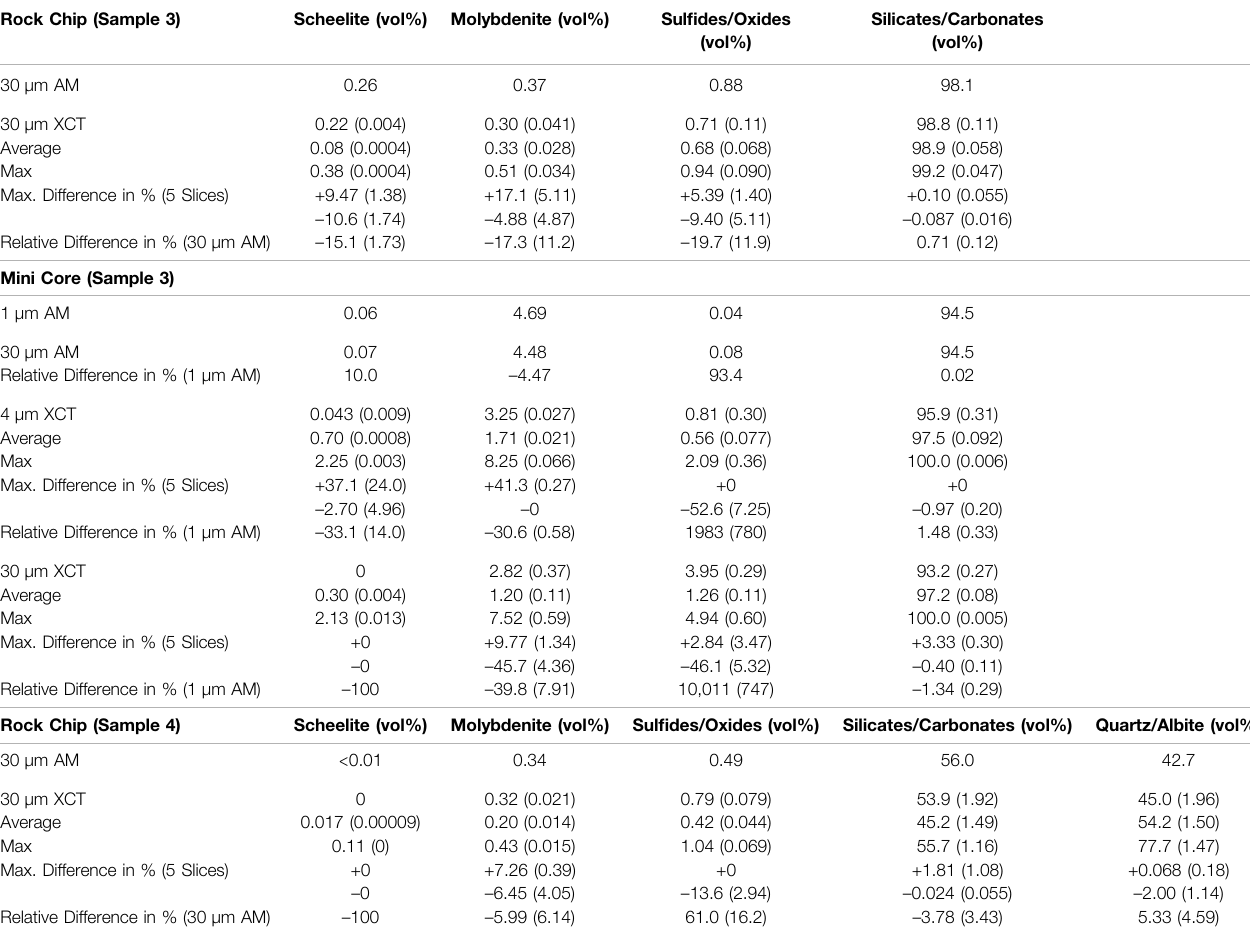
TABLE 4 | Comparison of the area percentage of the classes segmented in the rock chip and mini core of samples 3 and 4 between the AM mineral maps and the correspondingsliceofthedifferentXCTscans.Additionally,themaximaldifferenceinpercentbetweentheXCTsliceusedforcomparison withAMandthefollowingfour slicesisshown.AverageandMaxvaluesrefertoallsliceswithinaspeci fi csegmentedvolume(rockchip,minicore)ofanXCTdataset.TheXCTvaluesarethemeanvaluesof six segmentations (n (cid:2) 6) of the same volume, with the standard deviation in brackets. Rock Chip (Sample